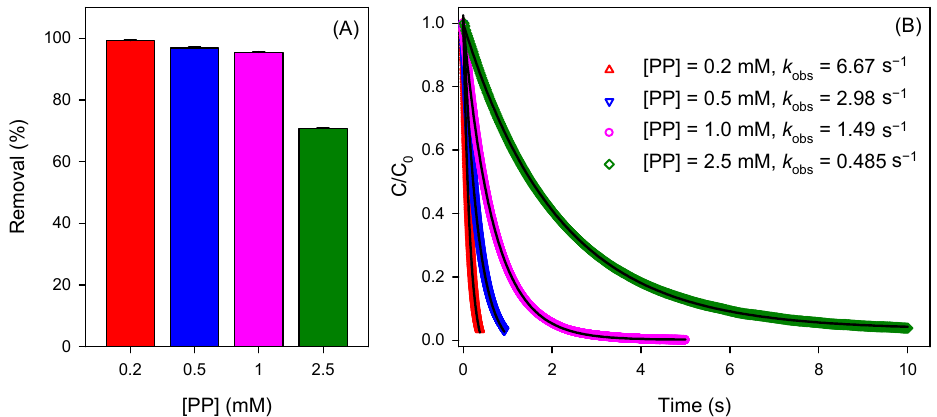
Figure 4. ( A ) Influence of the concentration of PP on CBZ degradation by the Mn(III)/HSO 3 − process at pH 7.0; conditions: [CBZ] 0 = 5 µM, [Mn(III)] 0 = 50 µM, [HSO 3 − ] 0 = 250 µM. ( B ) The reduction kinetic of Mn(III) by HSO 3 − in the presence of different concentrations of PP at pH 7.0; conditions: [Mn(III)] 0 = 50 µM, [HSO 3 − ] 0 = 2 mM, the black line represents the fitting curve.